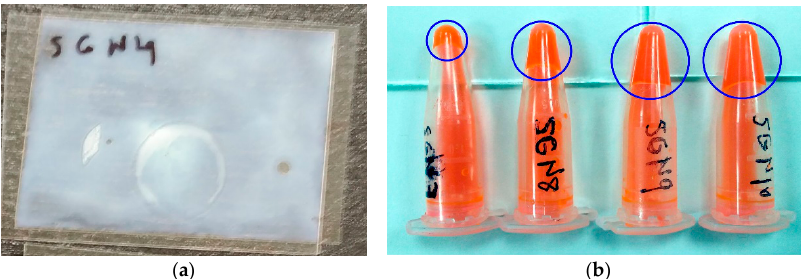
Figure 5. ( a ) Opaque sample by arrangement of LC molecules due to low ambient temperature. ( b ) Polymerized solution inside the blue circle due to high temperature during the preparation of the